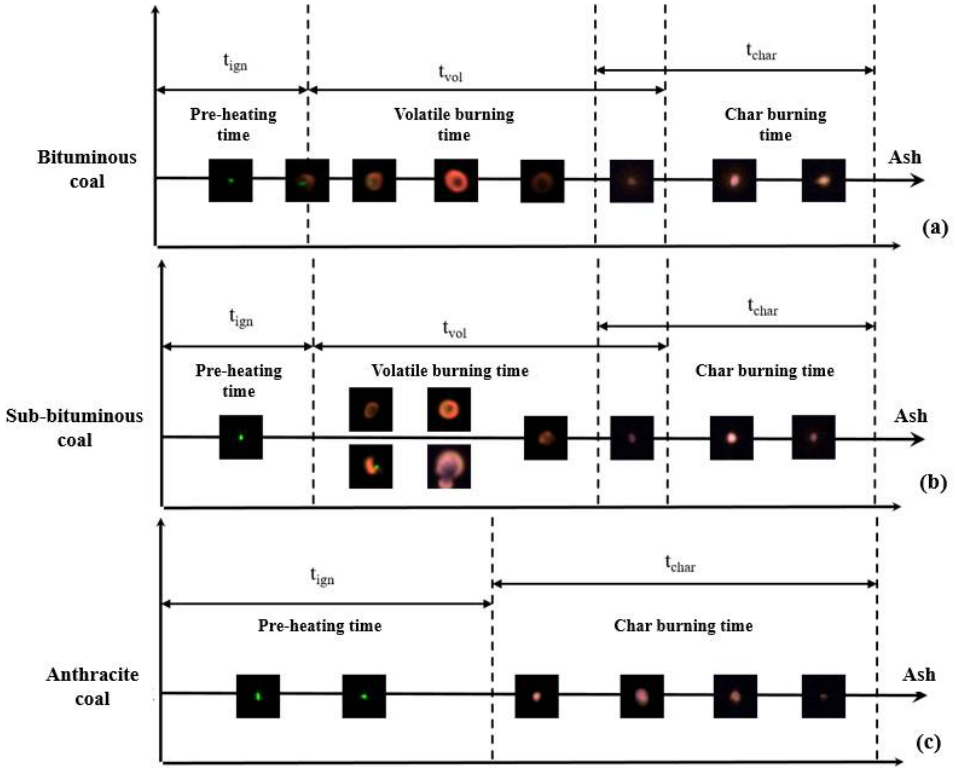
Figure 9. ( a ) The ignition process of SH bituminous coal; ( b ) the ignition process of PRB sub-bituminous coal; ( c ) the ignition process of SX anthracite coal.